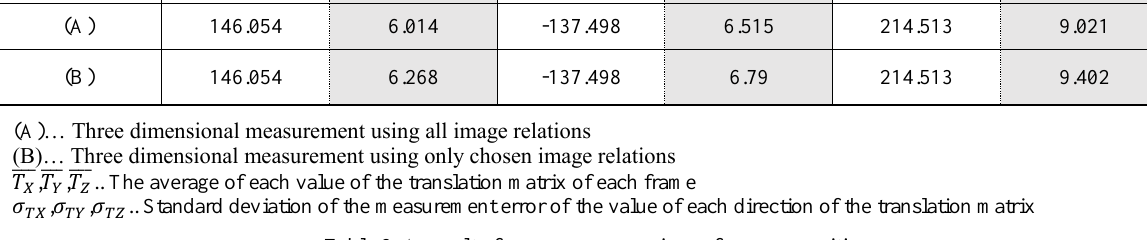
Table 3. A result of accuracy comparison of camera